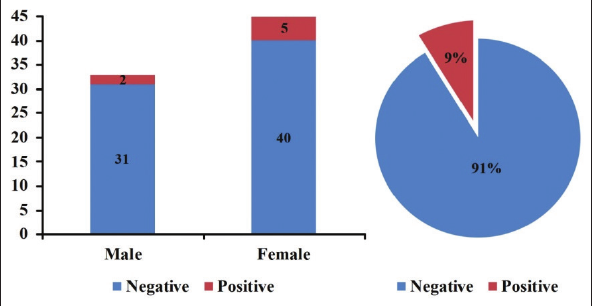
Figure-1: Seropositivity against canine hepatitis B virus antigen, and the frequency of the infection according to the sex of study dogs in Nineveh Province,